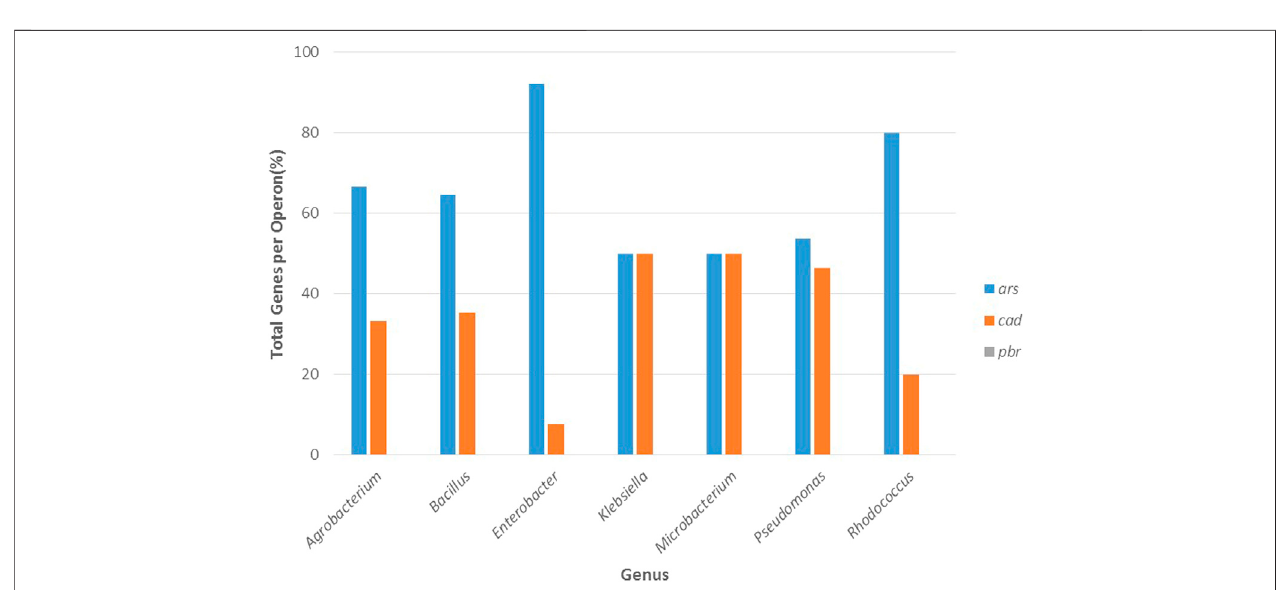
FIGURE 8 | Total percentage of genes by operon: ars, cad, and pbr for arsenic, cadmium, and lead resistance, respectively, in function of the most resistant bacterial genera ( Agrobacterium, Bacillus, Klebsiella, Enterobacter, Microbacterium, Pseudomonas, and Rhodococcus ).